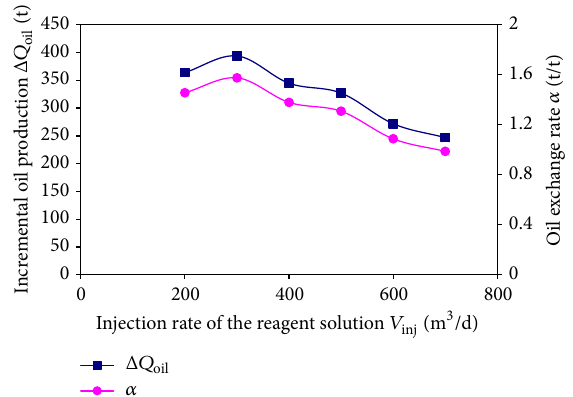
Figure 13: The incremental oil production and oil exchange rate at different reagent solution injection rates.